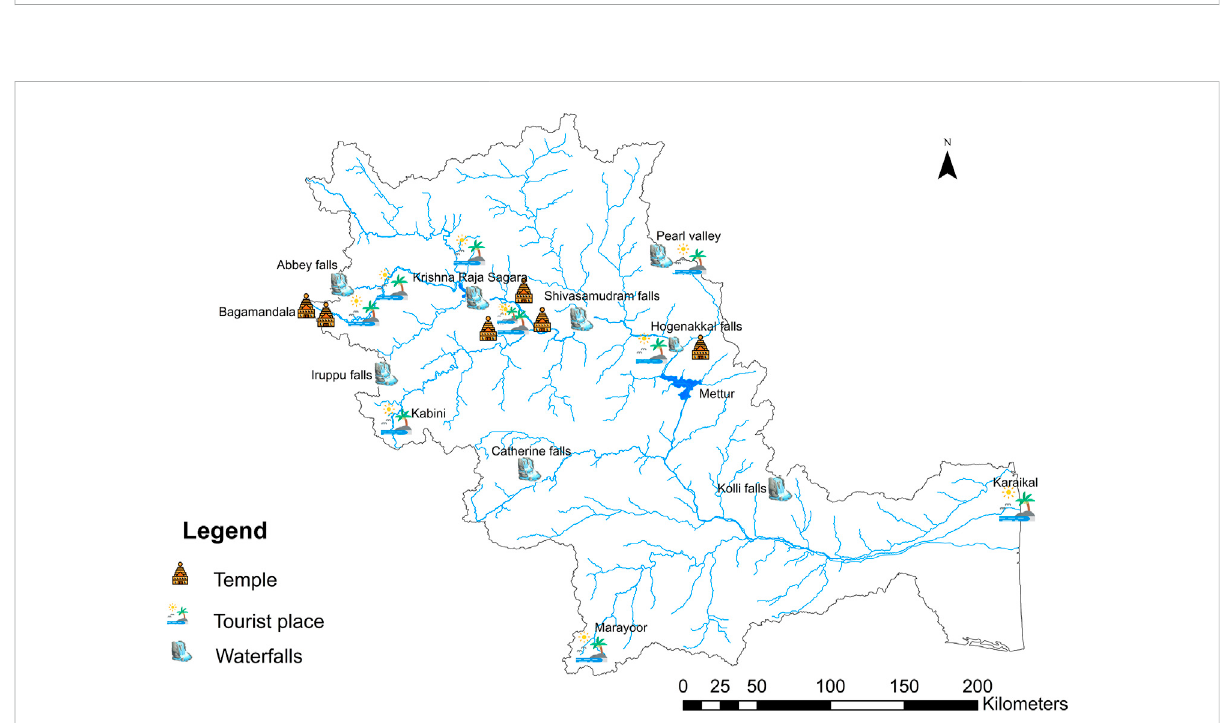
FIGURE 4 An overview of major cultural services in the cauvery